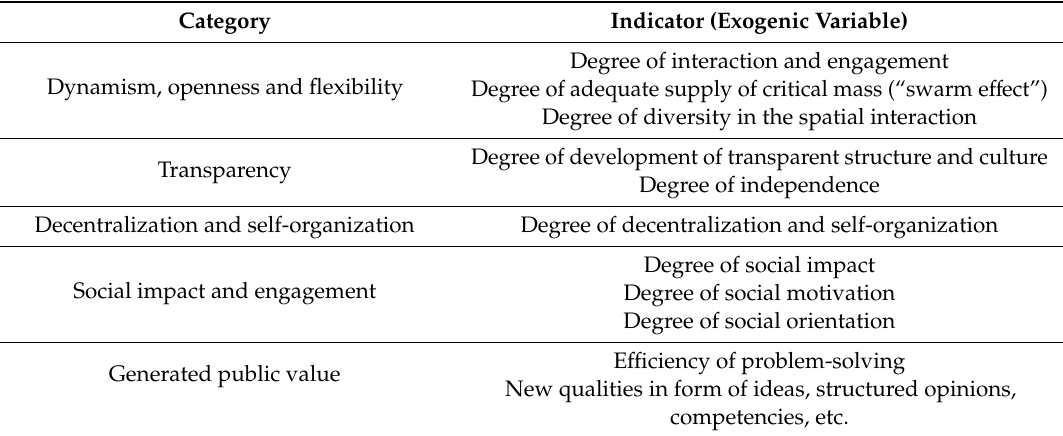
Table A3. The structure of POS QI.